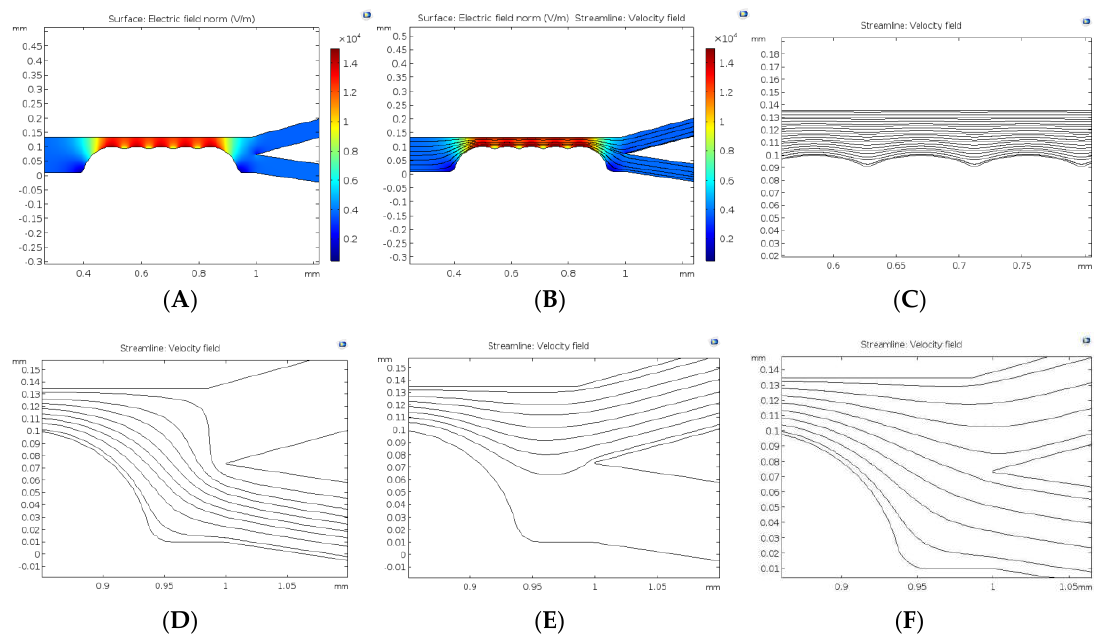
Figure 6. Field and velocity profiles obtained from solving the electrostatics and stokes equations in stationary mode. ( A ) is the electric field norm, ( B ) is the combination of the field norm with velocity streamlines, ( C ) is the zoomed image showing the effect of the constriction zone on velocity streamlines. ( D – F ) show streamlines based on changing DC voltage at 10 V, 110 V and 60 V respectively. The constriction diameter and number were fixed to be 100 μm and 5 respectively.